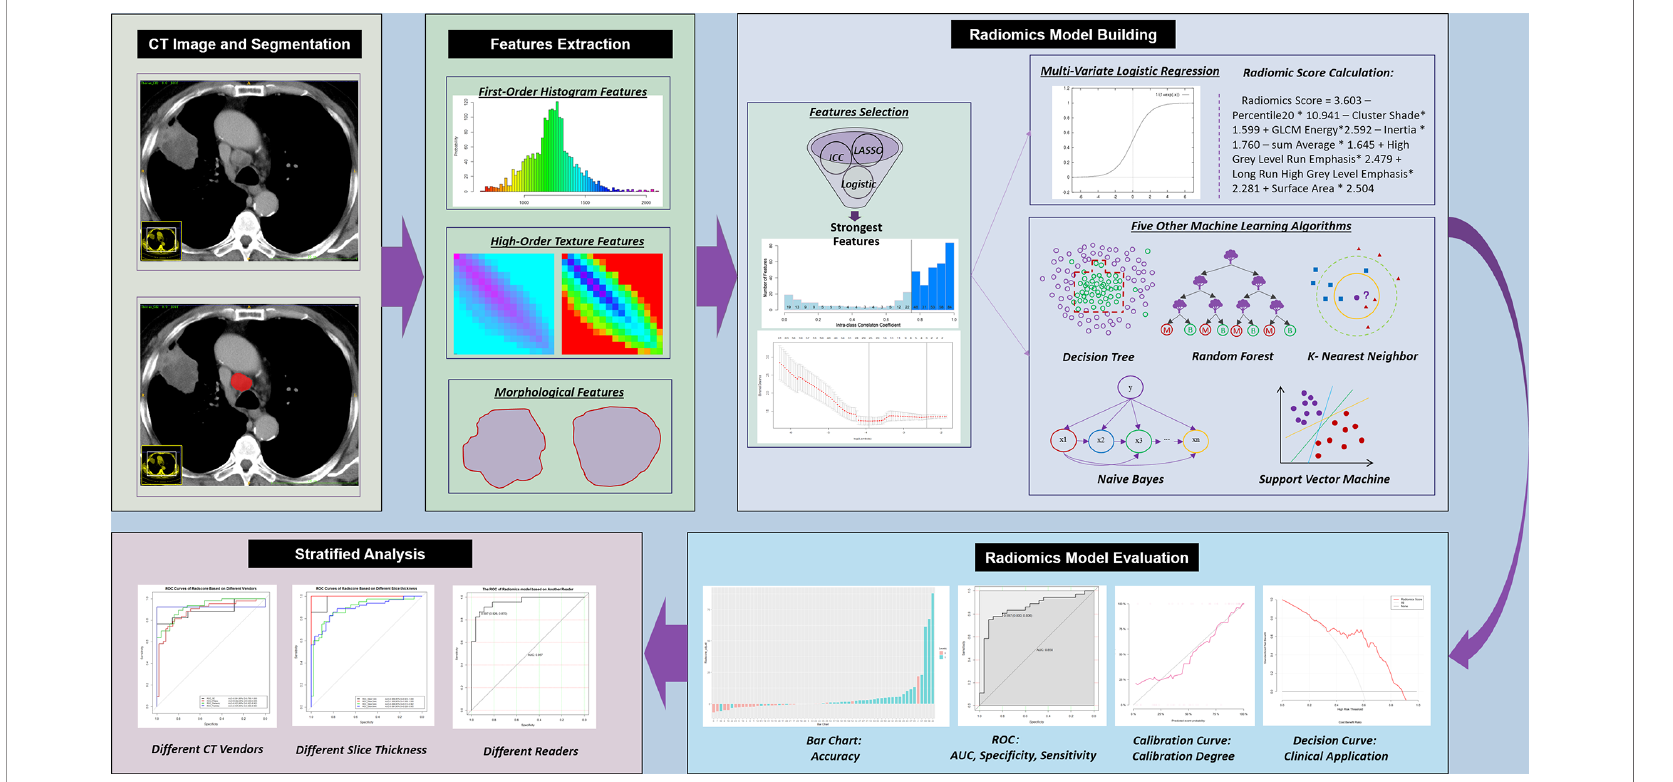
FIGURE 2 | Work fl ow of the current study. CT, computed tomography; ICC, intraclass correlation coef fi cient; LASSO, least absolute shrinkage and selection operator; ROC, receiver operating characteristic; AUC, area under the ROC